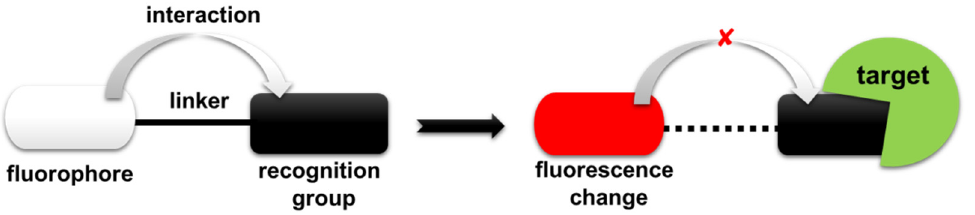
Figure 1. Design principle and sensing mechanism of fluorescent probes targeting